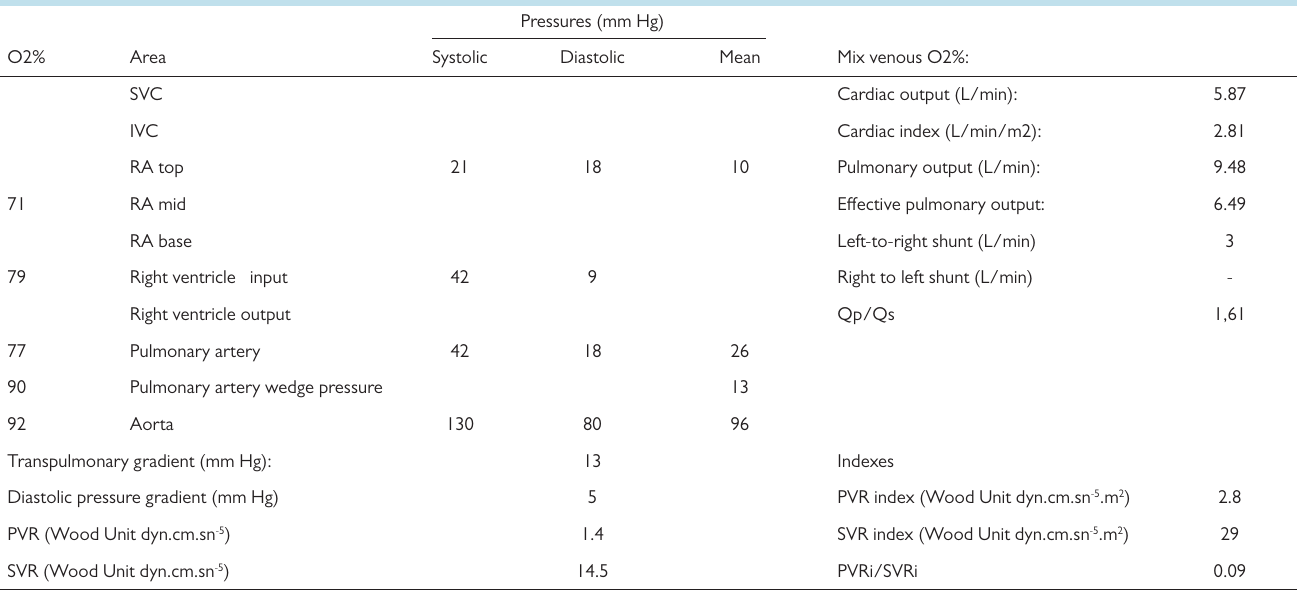
Table 1. Right Heart Catheterization and Shunt